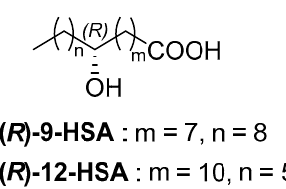
Figure 1. Structures of (R) -9-hydroxystearic acid ((R) -9) and 12-HSA.